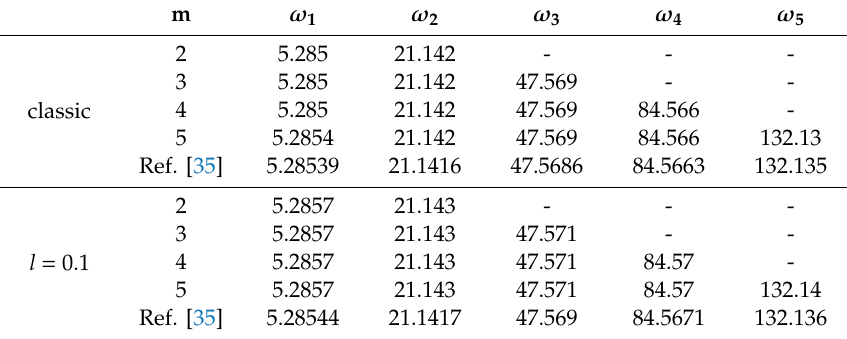
Table 1. Convergence study for first five natural frequency of the S-S three-layer [90 ◦ ,0 ◦ ,90 ◦ ] Euler–Bernoulli